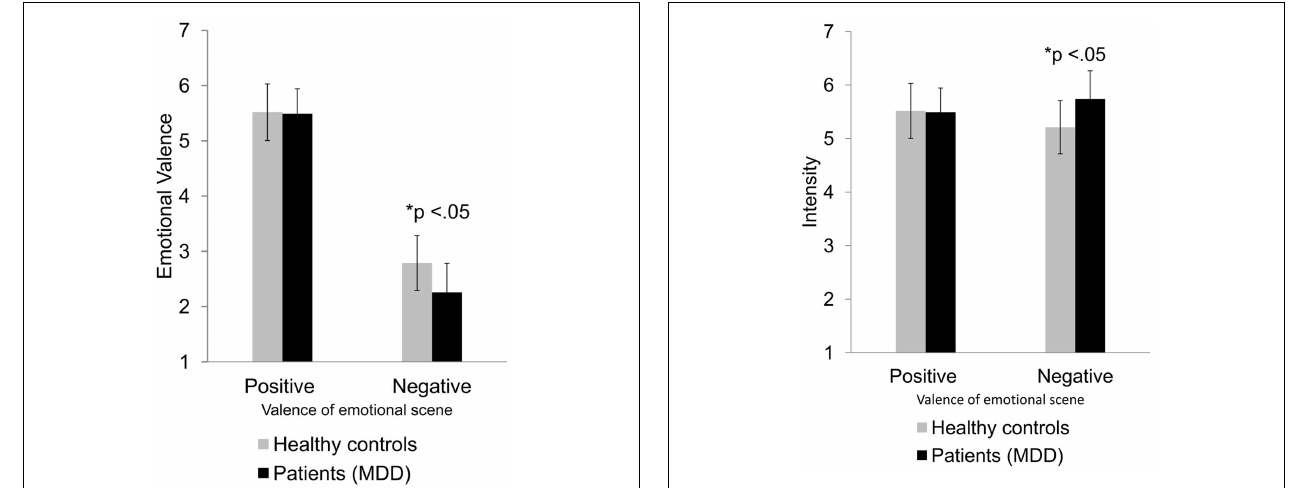
classificationswascorrect.Implementingthecontrolsessioneither